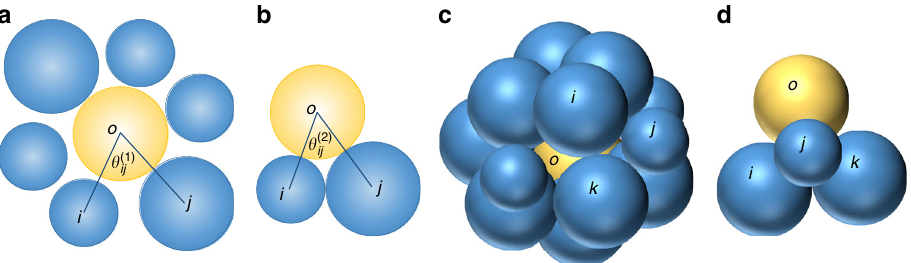
Fig. 6 De fi nition of the structural order parameter. The panels a and b are for a 2D disk system. a A typical local particle con fi guration consisting of a central particle, o , and its 6 neighbours. We denote two of the neighbours next to each other as i and j . b The reference con fi guration corresponding to that in panel a, where the three particles i , j , and o , just touch with each other. We de fi ne the central angles of con fi gurations in panels a and b and denote them as θ ð 1 Þ and θ ð 2 Þ , respectively. The panels c and d are for a 3D sphere system. c A typical local particle con fi guration consisting of a central particle, o and its ij ij 14 neighbours. We denote three of the neighbours next to each other as i , j , and k . d The reference con fi guration corresponding to that in panel c , where the four particles, i , j , k , and o , just touch with each other. We describe the detailed de fi nition of the structural order parameter for the instantaneous liquid states in the main text.